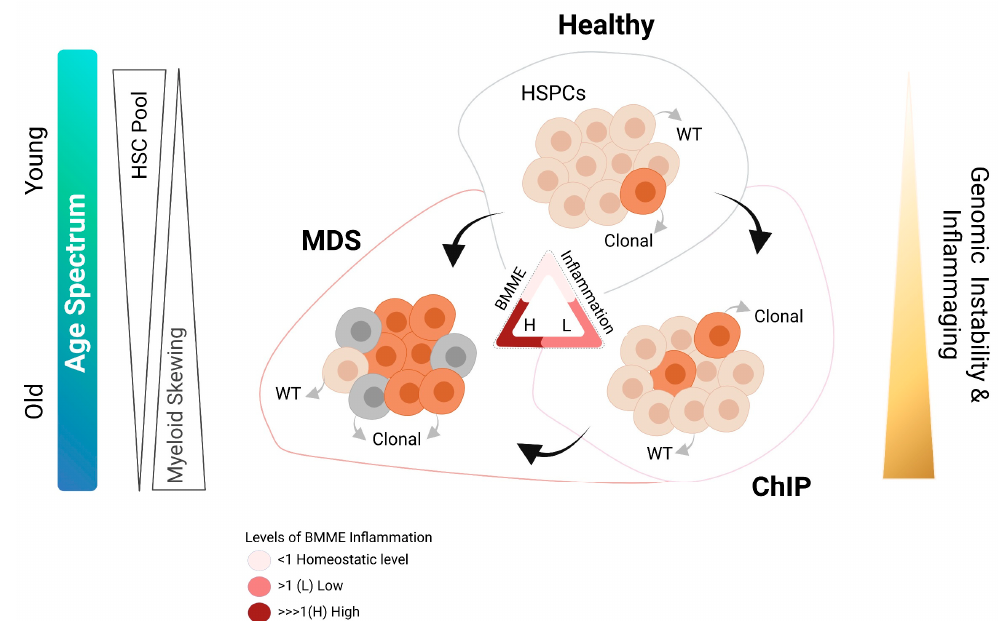
Figure 1. Schematic representation showing possible routes to MDS. Somatic mutations are known to occur in the hematopoietic stem cells (HSCs) during normal DNA replication. The basic premise of the long-standing idea is that a cell that is endowed with an advantageous mutation produces a progeny with increased fitness, which is selected and eventually flourishes. During the early stages of life, bone marrow inflammation is at homeostasis. However, with increasing age, genomic instability, age-related inflammation (Inflammaging) and external environmental cues, these ‘potent’ clones accumulate in the bone marrow, reaching a stage known as clonal hematopoiesis of indeterminate potential (ChIP). Notably, all hematopoiesis is clonally derived; however, malignancy can arise when the hematopoiesis become abnormal or marked by acquisition of additional mutations. Therefore, ChIP can turn to MDS once clinical manifestations of the disease are diagnosed. On the other hand, clonal selection and acquisition of certain mutations (with or without additional external factors) can directly result in switching from healthy stage to MDS. As the bone marrow ages, HSC pool becomes depleted with increasing inflammaging and these cells become skewed towards myeloid lineage. Illustration was created with BioRender.com (accessed on 28 June 2021).